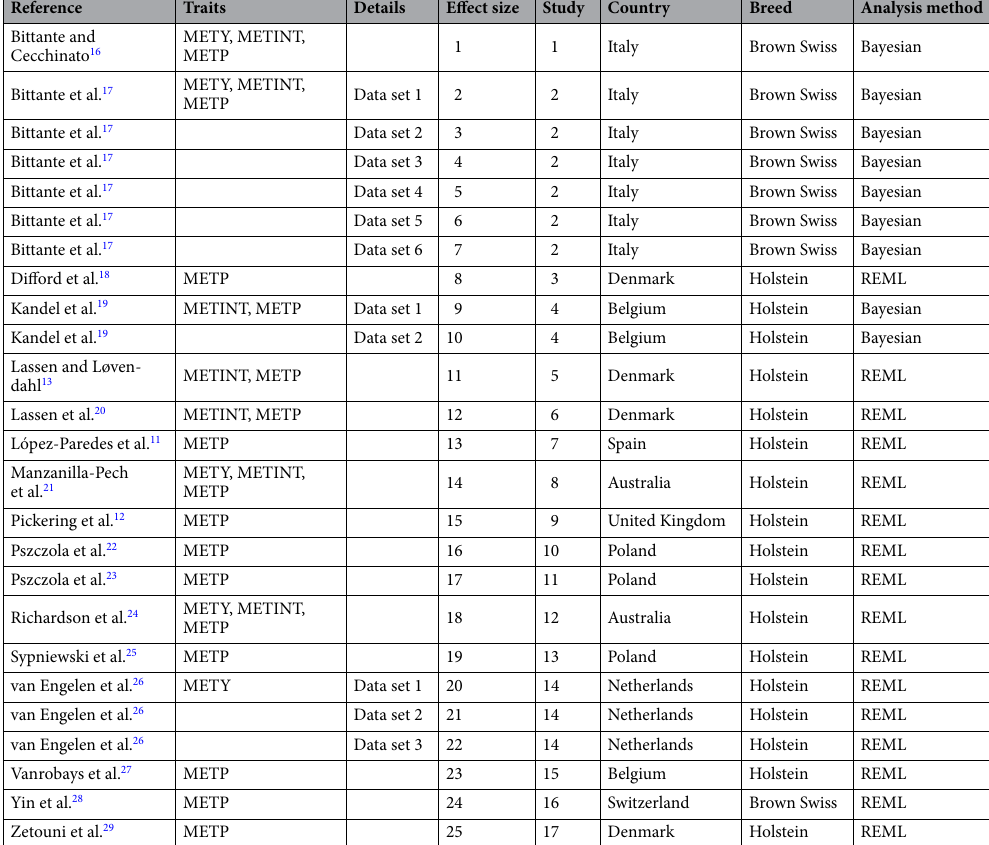
Table 1. The characteristics of studies included in the database for conducting this meta-analysis. METY, Methane yield; METINT, Methane intensity; METP, Methane